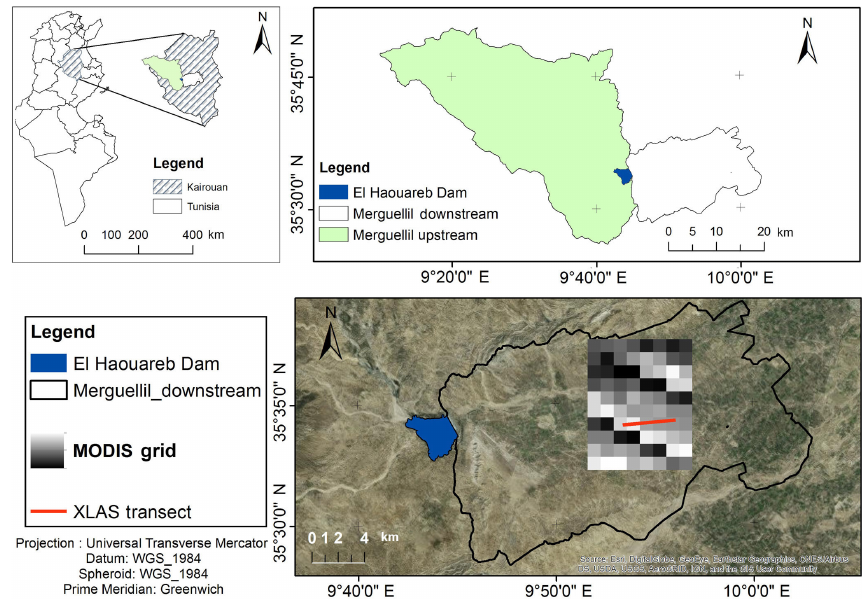
Figure 1. The study area: the downstream Merguellil subbasin is the so-called Kairouan plain; the MODIS grid is the extracted 10km × 8km MODIS subimage and in red the scintillometer XLAS